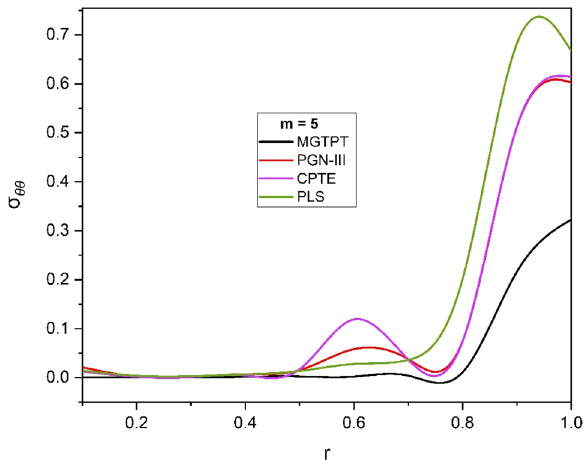
Fig. 11 The change in hoop stress with different